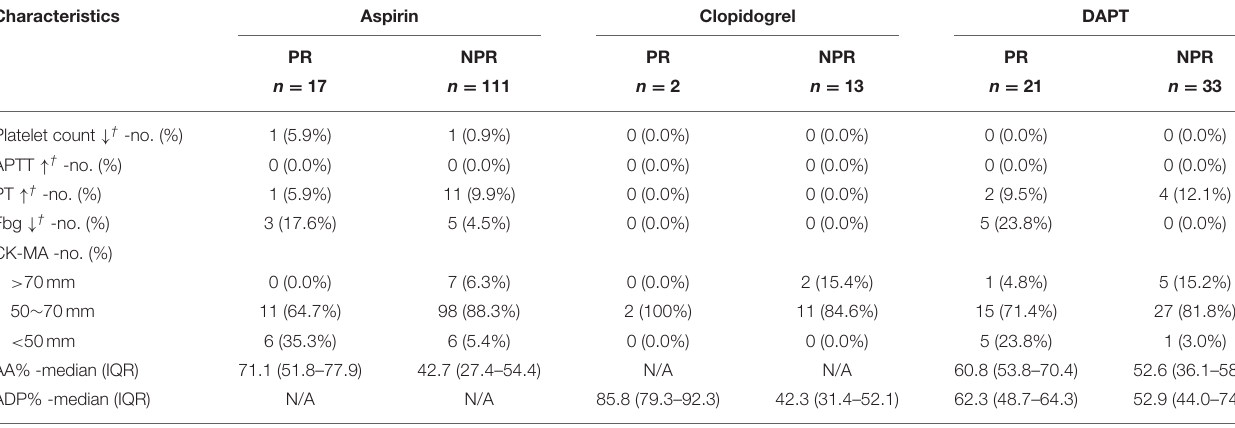
TABLE 2 | The information of preoperative coagulation characteristics. Characteristics Aspirin Clopidogrel DAPT PR NPR PR